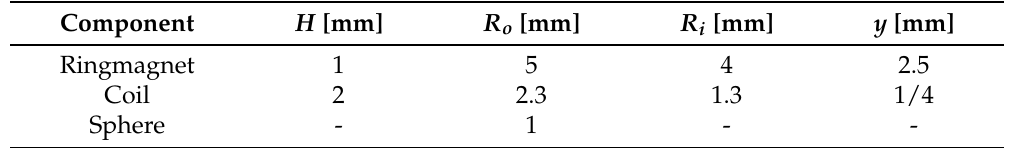
Table 1. Dimensions of the catch actutator’s components. H corresponds to a part’s height, R o to the outer radius and R i to the inner radius. The vertical position y refers to center of